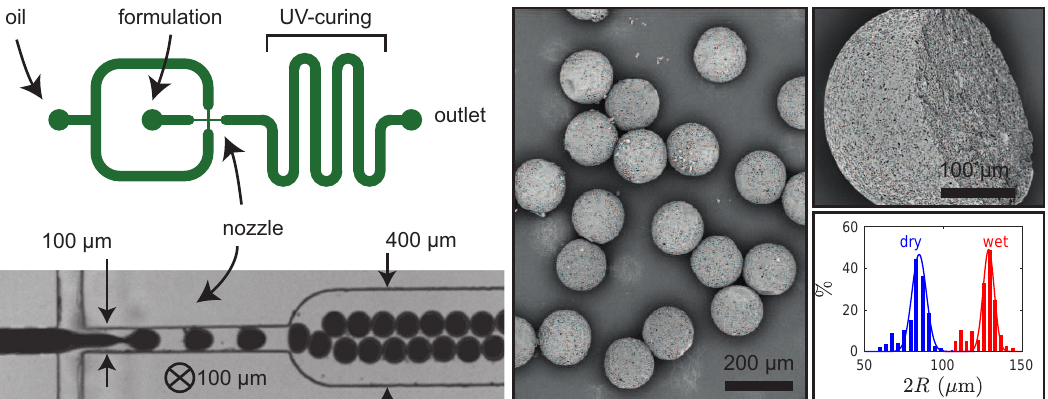
Figure 7. Batch particles produced by manual emulsification followed by UV-curing. ( A ) low density of calcite (before and after removal of calcite, left and right respectively where the calcite particles show as bright spots); ( B ) high density of calcite after its removal.